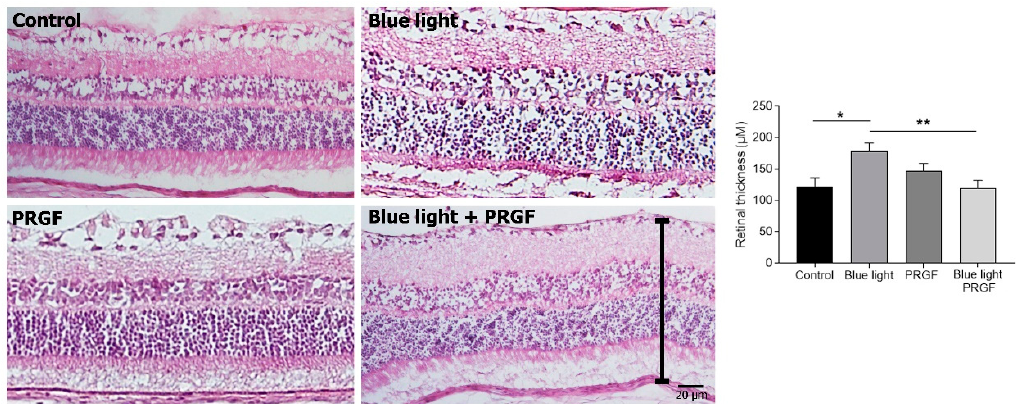
Figure 3. Hematoxylin and eosin (H&E) staining of transversal sections of experimental retinas ( n = 4). PRGF combined with blue light maintained the tissue close to control conditions. However, blue light disrupted the retina’s integrity. Means of quantification thickness showed that there were significant differences between the result obtained from blue-light-exposed retinas and those treated with a combination of blue light and PRGF. Statistical analysis: One-way ANOVA, Sidak’s multiple comparison test, * p < 0.05 and ** p < 0.005. Scale = 20 µm.